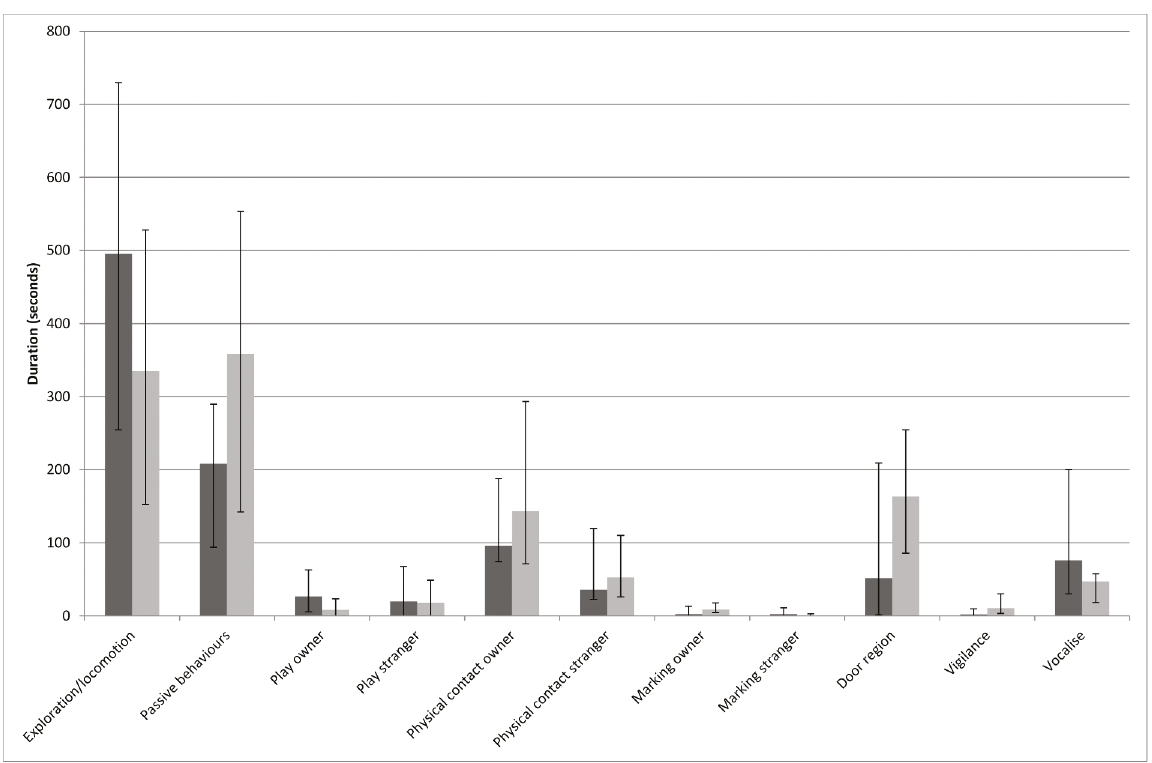
Fig 2. Median time (and interquartile range) in seconds, spent in various activities by cats in the two conditions. Darker bar refers to condition A and lighter bar to condition B.